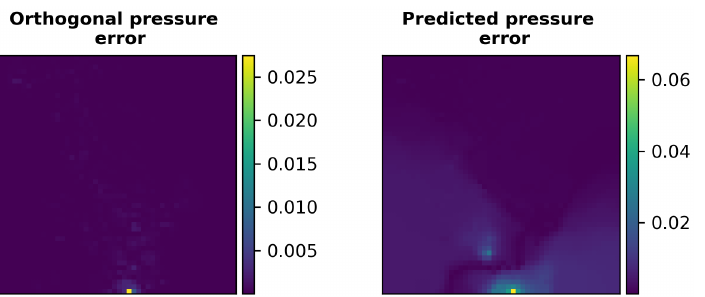
Figure 39. Comparison of the relative error in pressure due to orthogonal projection ( left ) and ML-predicted solution ( right